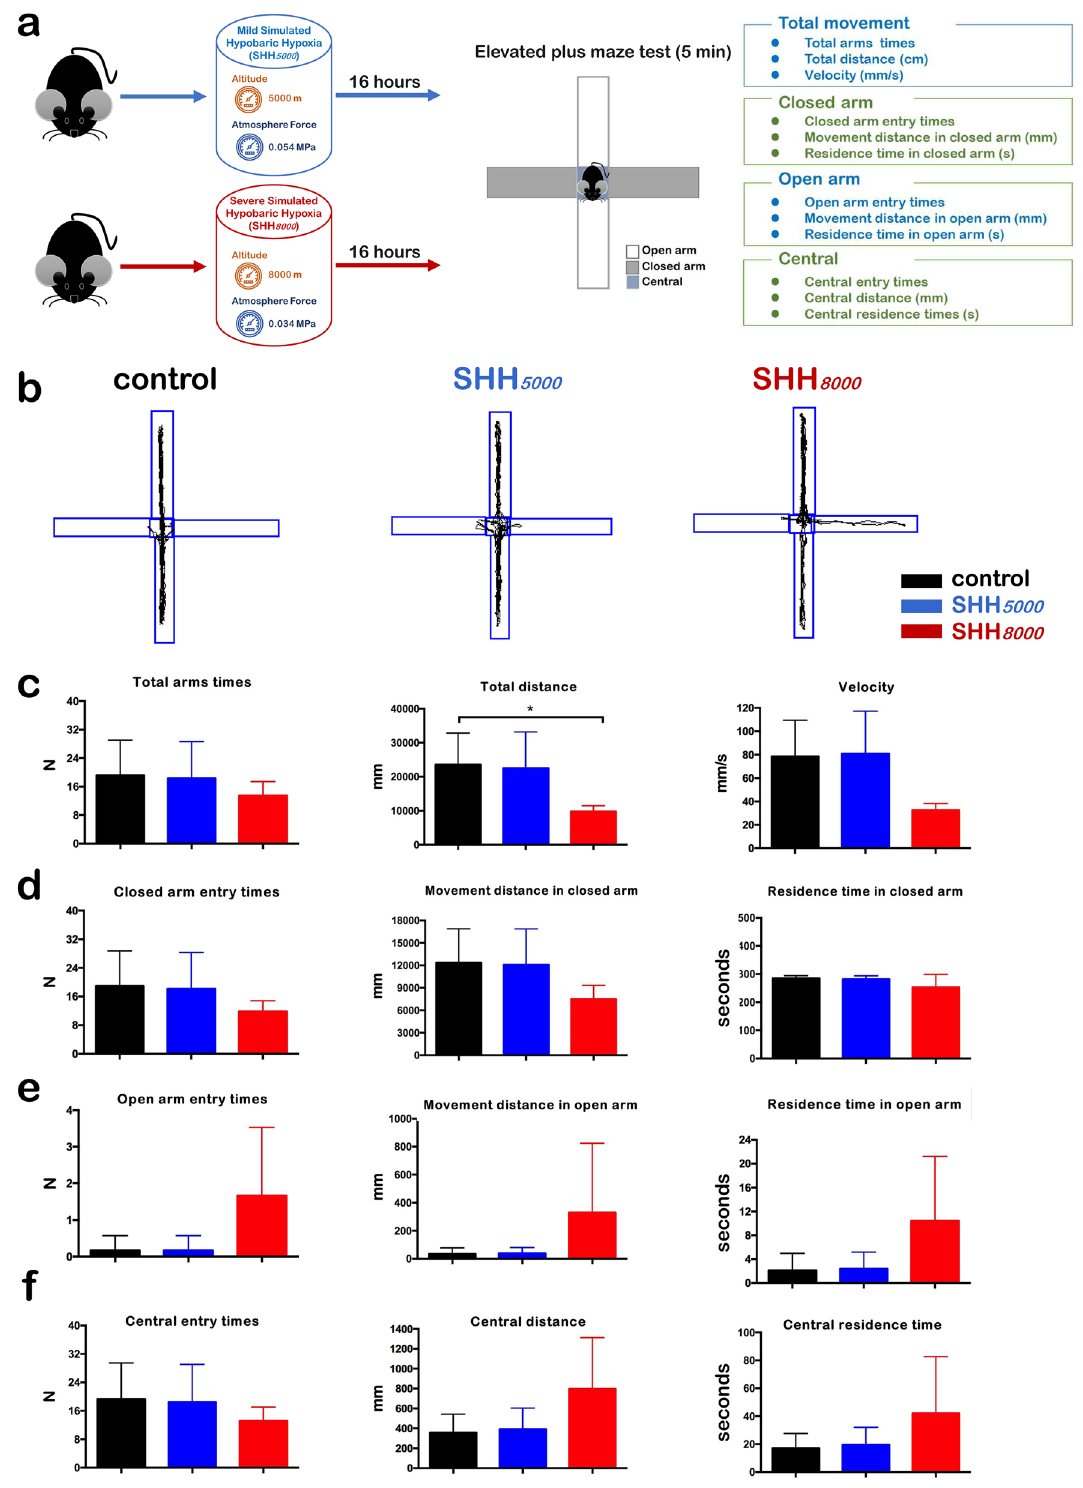
Figure 3. Mice presented improved exploratory behaviors under SHH conditions. ( a ) Scheme of the elevated plus maze test after 16 h of SHH 5000 or SHH 8000 treatment aiming to examine the exploratory behaviors of mice. ( b ) Trajectory pattern diagram after SHH 5000 or SHH 8000 treatment. ( c ) Total arms times, total distance and speed (from left to right). ( d ) Closed arm entry times, movement distance in the closed arm and residence time in the closed arm (from left to right). ( e ) Open arm entry times, movement distance in the open arm and residence time in the open arm (from left to right). ( f ) Central entry times, central distance and central residence time (from left to right). Each value is expressed as the mean ± standard error of the mean. Multiple comparisons between groups were carried out with Tukey’s post hoc test. *P value < 0.05; **P value < 0.01; ***P value < 0.001, n = 5 per